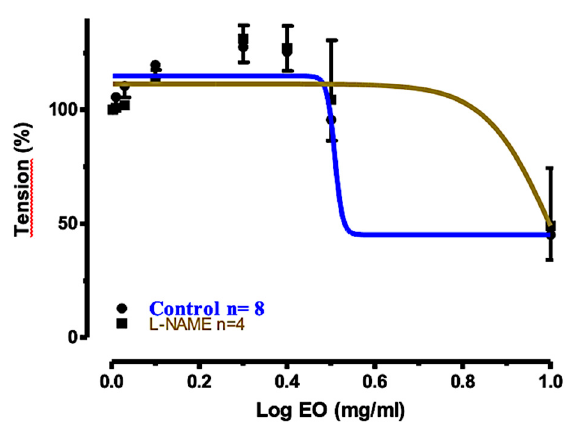
Figure 6. Concentration–response curves for the relaxant effects of EO S on rat tracheal rings precontracted with ACh (10 µ M): control and preincubated with L-NAME (0.3 mM). Table 3. Relaxant effects of volatile fractions (EO S ) in tracheal rings preincubated with K + and Ca 2+